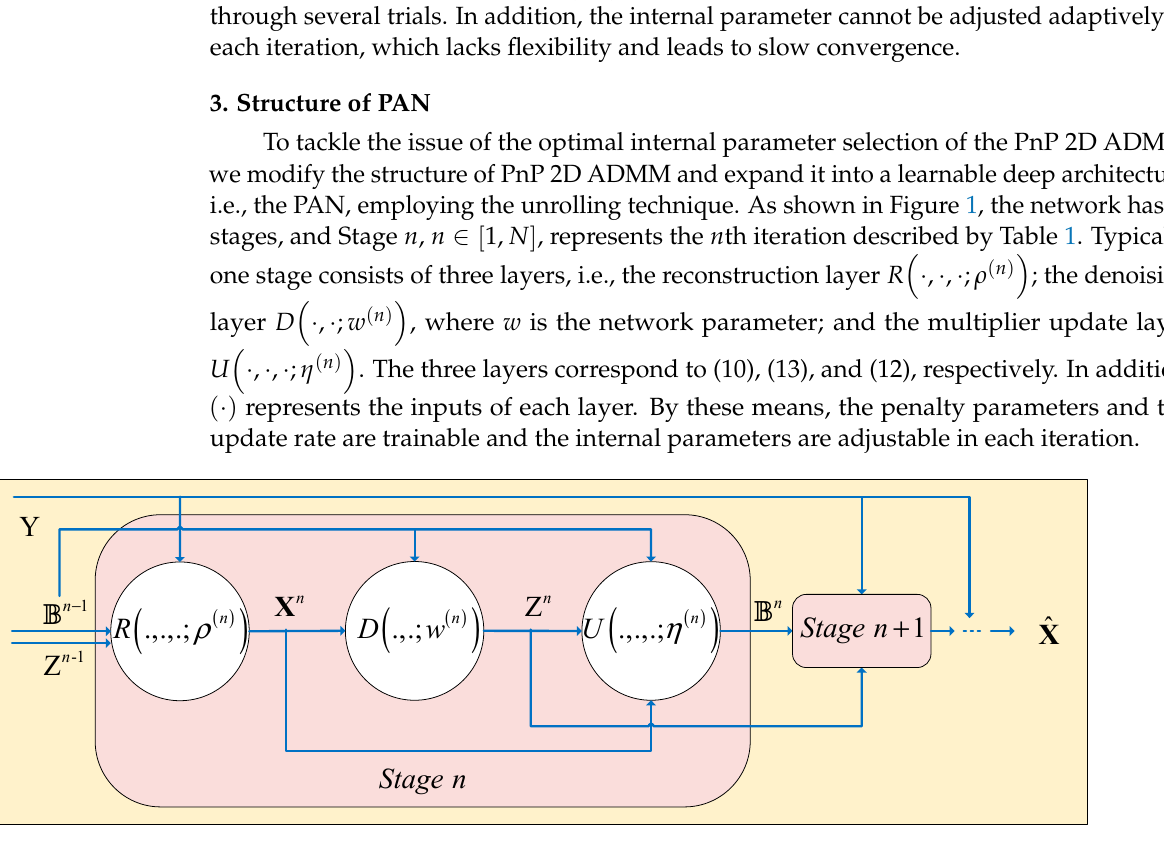
Figure 1. Structure of the PAN. Table 1. Performance evaluation for the simulated 2D incomplete data under 5 dB